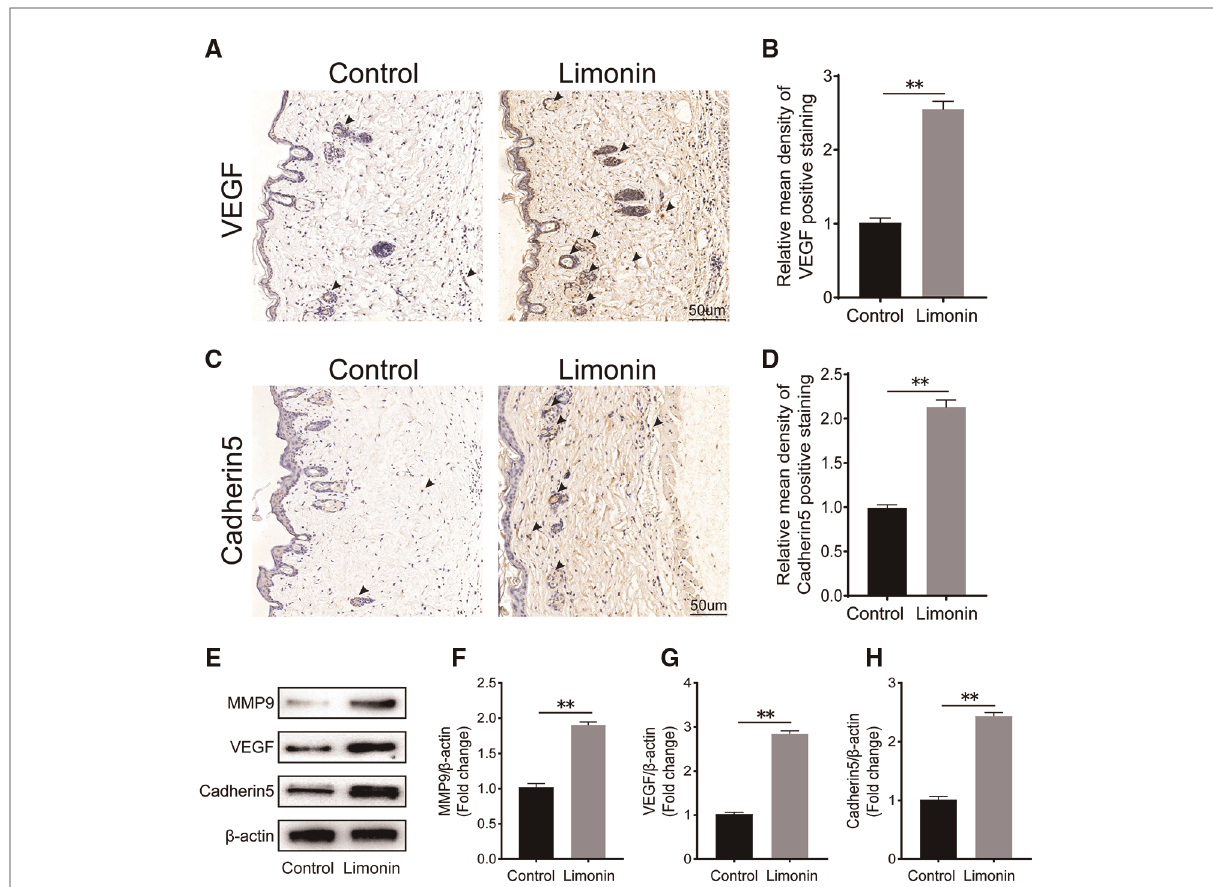
FIGURE 3 Limonin enhances angiogenesis in the ischemic area of the fl aps. ( A,C ) Immunohistochemistry for vascular endothelial growth factor (VEGF) and cadherin 5 expression in the fl aps of the control and limonin groups (original magni fi cation ×200; scale bar, 50 µm). ( B,D ) Histograms of optical density values for VEGF and cadherin 5 by immunohistochemistry in each group. ( E ) Western blotting of the levels of VEGF, matrix metalloproteinase 9 (MMP9), and cadherin 5 in the control and limonin groups. Gels were electrophoresed under the same experimental conditions, and cropped blots are shown here. ( F – H ) Histograms of optical density values for MMP9, VEGF, and cadherin 5 as calculated by Western blotting. Data are mean±standard error of the mean, n =6 per group. * P <0.05 and ** P <0.01, vs. control